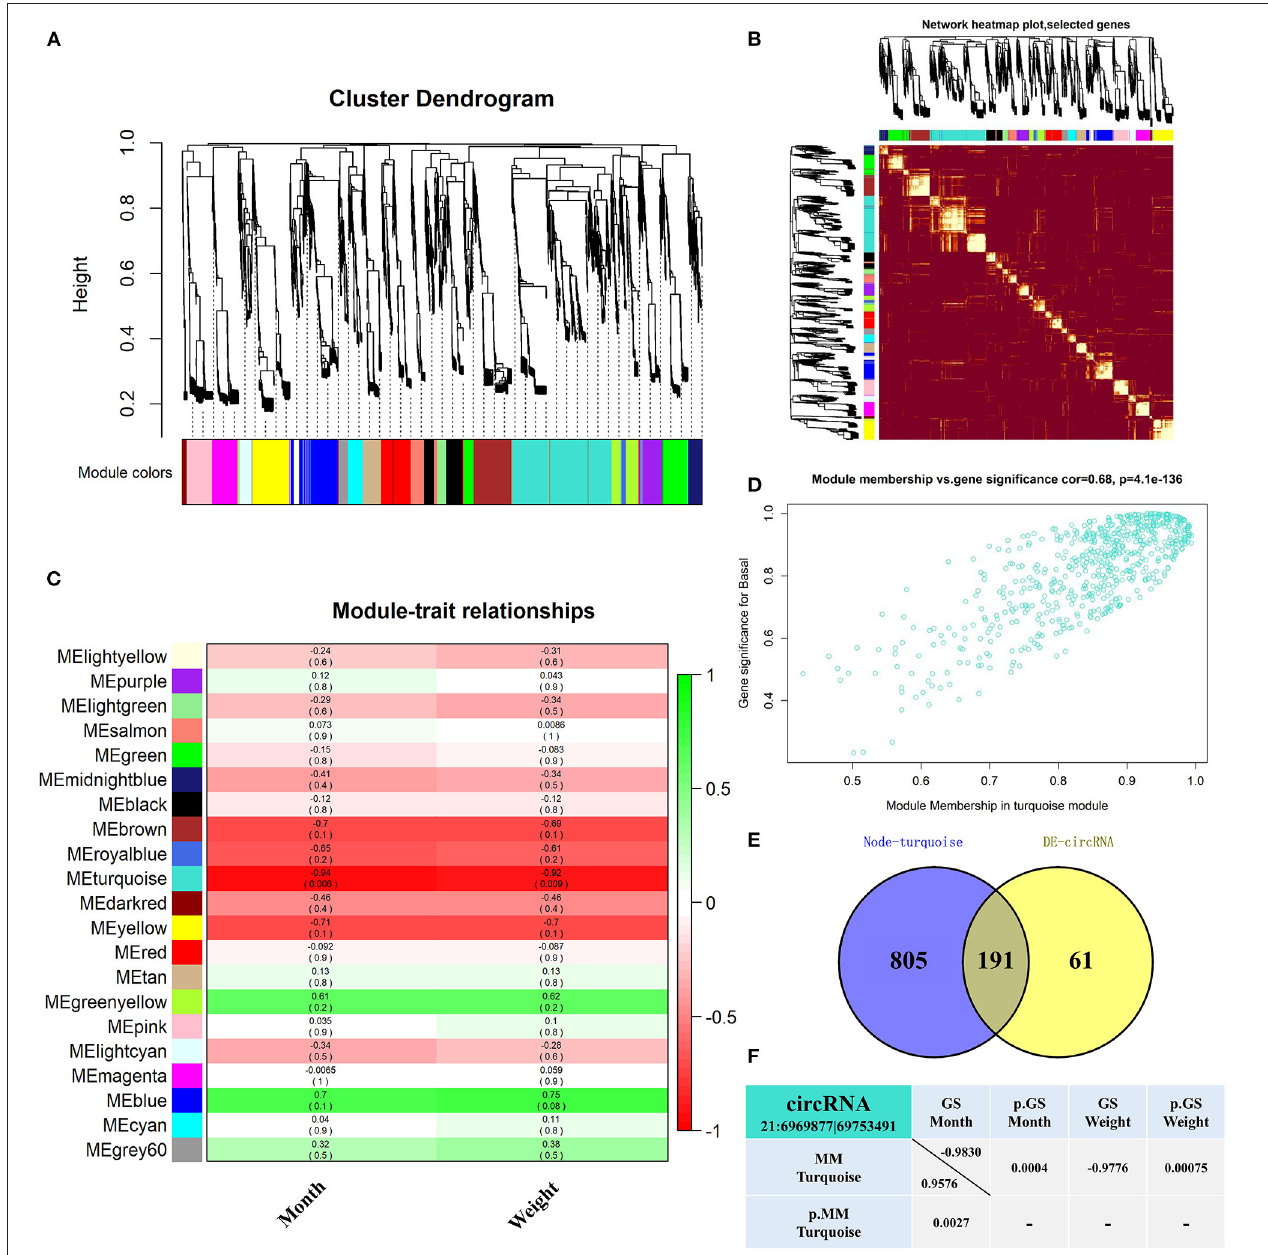
FIGURE 1 | Screened-out circRNAs significantly associated to buffalo fat deposition. (A–D) CircRNA co-expression network of adipose tissue in the Xinyang buffalo revealed by WGCNA; (A) Hierarchical cluster tree of co-expression modules, where every leaf on a tree is a circRNA and main branches are made up of 21 color-coded modules; (B) Construction of co-expression modules by WGCNA. Progressively more saturated red colors indicate higher overlap among these functional modules and blocks of lighter color along the diagonal are the gene modules. Module assignment gene and dendrograms are at the top and left, respectively; (C) Association analysis of gene co-expression network modules with trait, where each row corresponds to a module (name displayed on the left) and each column corresponds to a particular trait. Colors of the row/column intersection cells indicate the correlation coefficient between module and trait (positive-green and negative-red); (D) Scatterplot of Gene Significance (GS) For Traits vs. Module Membership (MM) in the turquoise module, with a highly significant correlation between GS and MM (one dot represents one gene in the turquoise module); (E) Overlapping circRNAs between DE circRNAs and co-expression turquoise module; (F) CircRNA 21:6969877|69753491 GS and MM values.